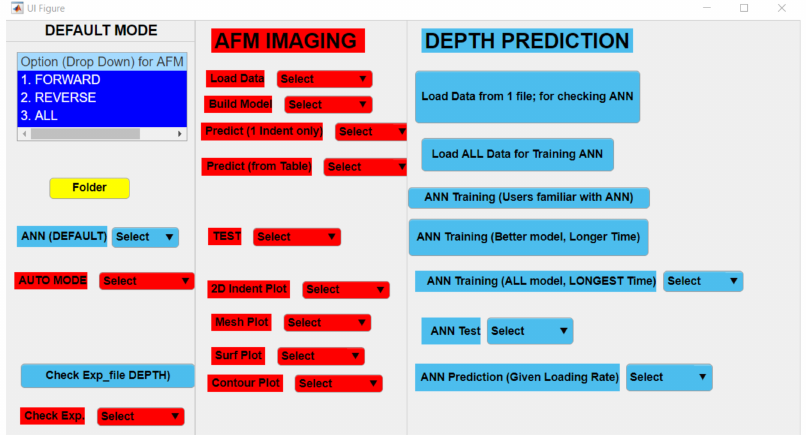
Figure 2. Layout of the